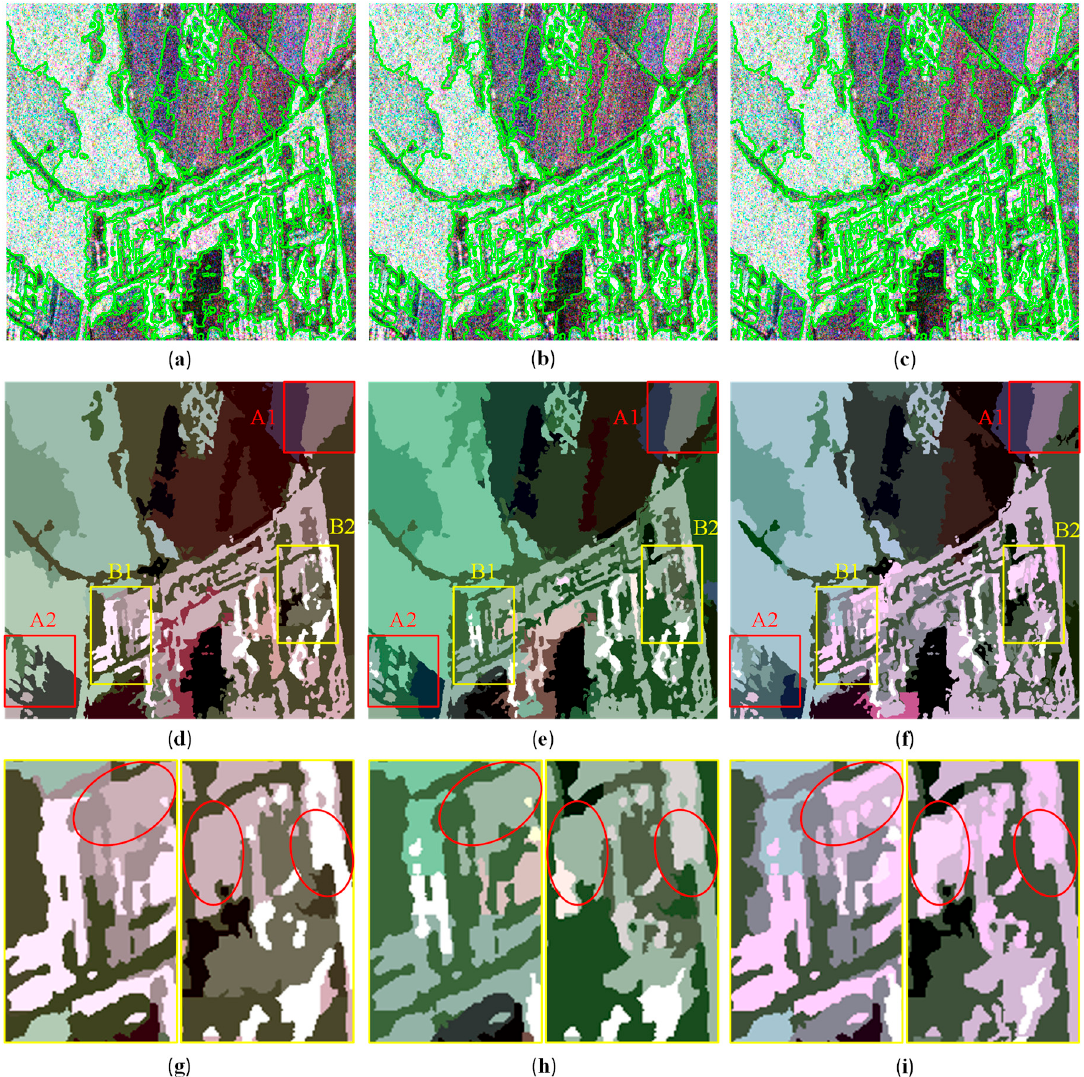
Figure 8. Comparison of the segmentation results of ESAR data. The first, second, and the third column show the results of IM-Wishart, IM-KummerU, and the proposed method, respectively: ( a )–( c ) are the final segmentation results, and the green lines depict the boundaries of the segmented regions. ( d )–( f ) give the corresponding representation maps. ( g )–( i ) show the enlarged images of area B1 and B2.